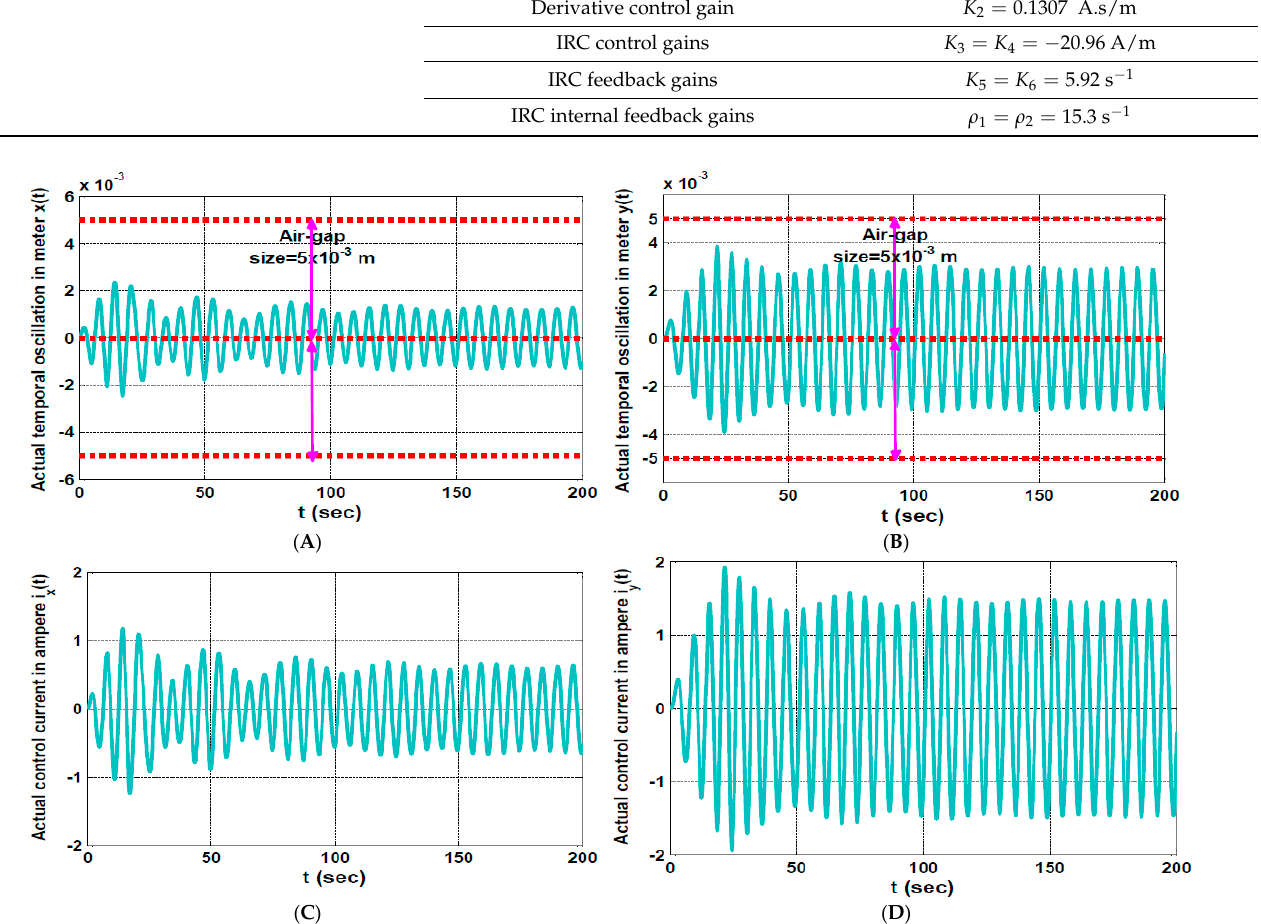
Figure 24. The actual lateral oscillations of 8-pole rotor system in 𝑋 and 𝑌 directions in meter, and Table 1: ( A , B ) the instantaneous oscillations of the rotor system in 𝑋 and 𝑌 directions, and ( C , D ) the instantaneous control currents of the controllers. Table 1: ( A , B ) the instantaneous oscillations of the rotor system in X and Y directions, and ( C , D ) the instantaneous control currents of the